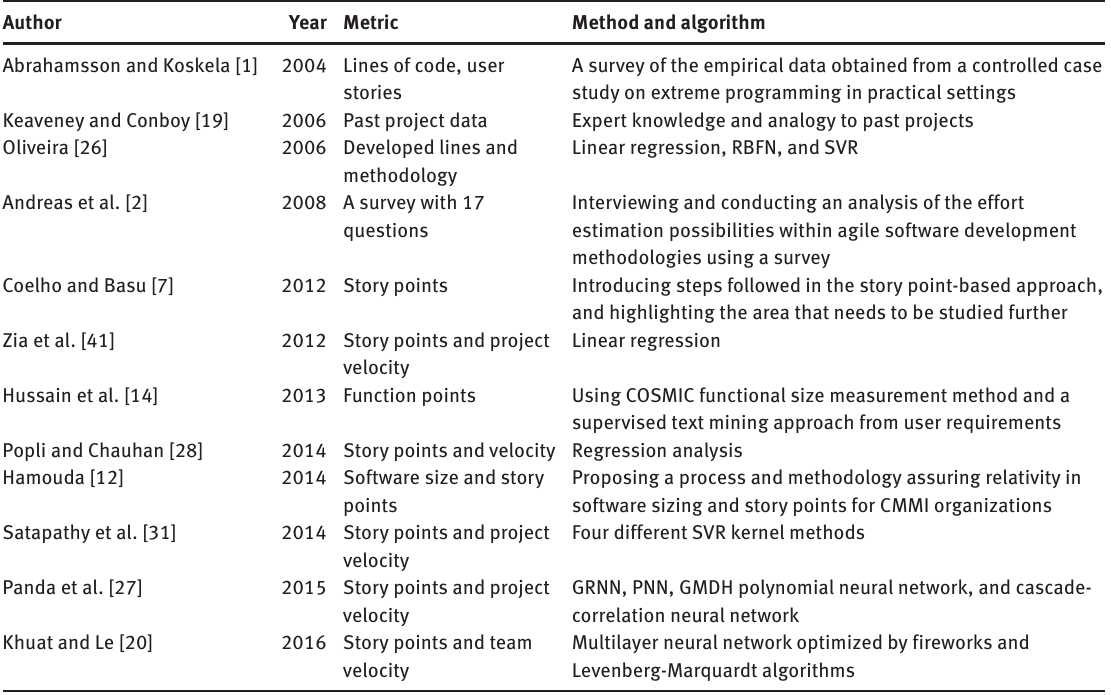
Table 1: Related Work on the Effort Estimation for Agile Software